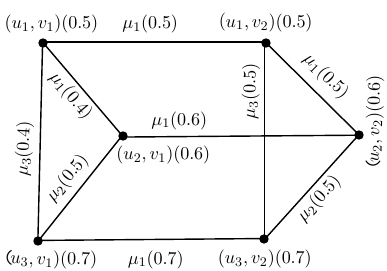
G 2 = ( σ , µ 1 , µ 2 , µ 3 ) (maximal product). Figure 4. G 1 Figure 4: G 1 G 2 = ( σ,µ 1 ,µ 2 ,µ 3 ) ∗ ∗ (Maximal Product)